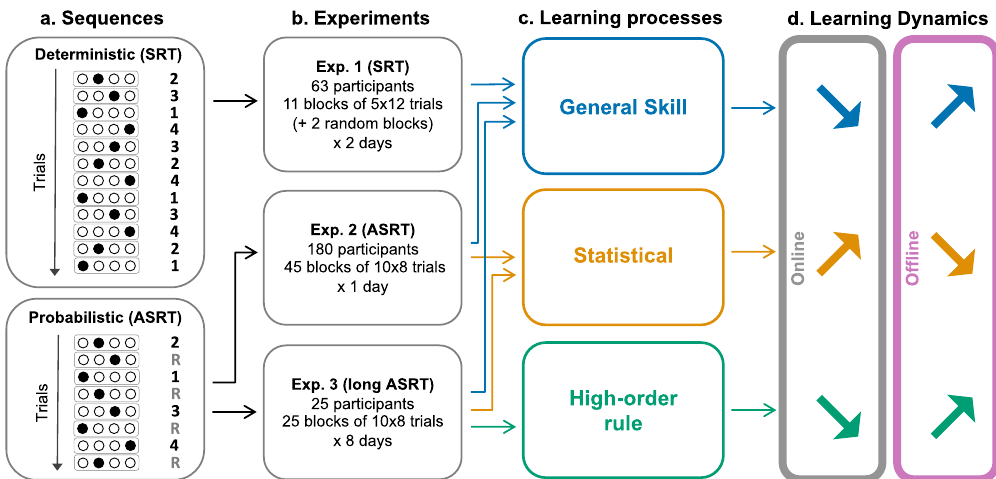
Fig. 1 General design and main results. a Structure of the sequences used in the SRT task and ASRT task. In the SRT task, a deterministic sequence of 12 elements is repeated fi ve times per block. In the ASRT task, a deterministic sequence of four elements is interleaved with four random elements resulting in an eight-element probabilistic sequence, which is repeated ten times per block. b The number of participants and sessions in Experiment 1 (SRT experiment), Experiment 2 (ASRT experiment), and Experiment 3 (long ASRT experiment). c Type of learning investigated in each experiment. d Summary of the results. General skill and high-order rule learning occur during rest periods (of fl ine) while statistical learning occurs during practice